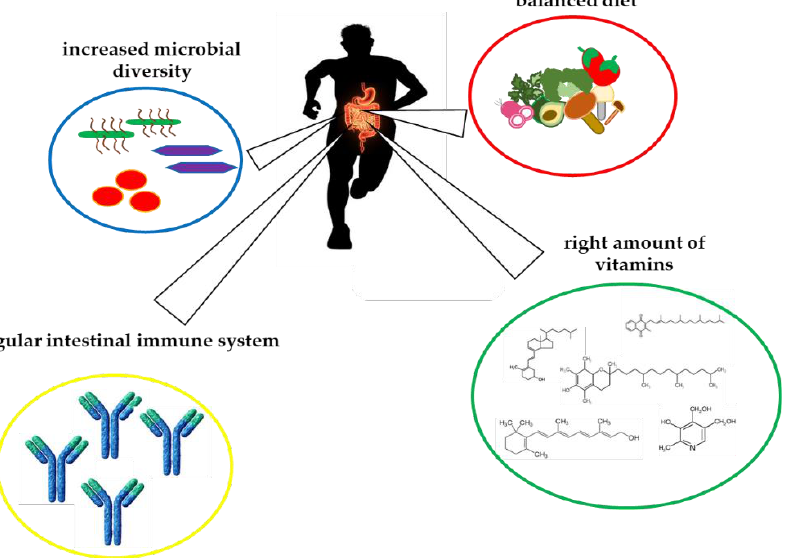
Figure 2. Schematic representation of the interplay between vitami ns and athletes’ gut microbiota.